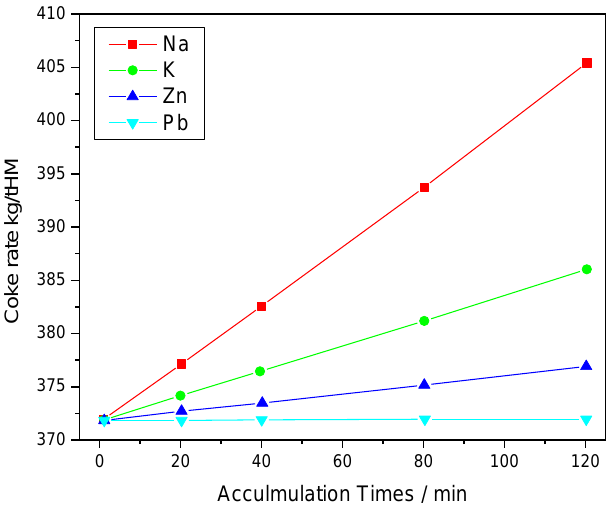
Figure 1. Effect of harmful elements on the gas utilization under various accumulation times.